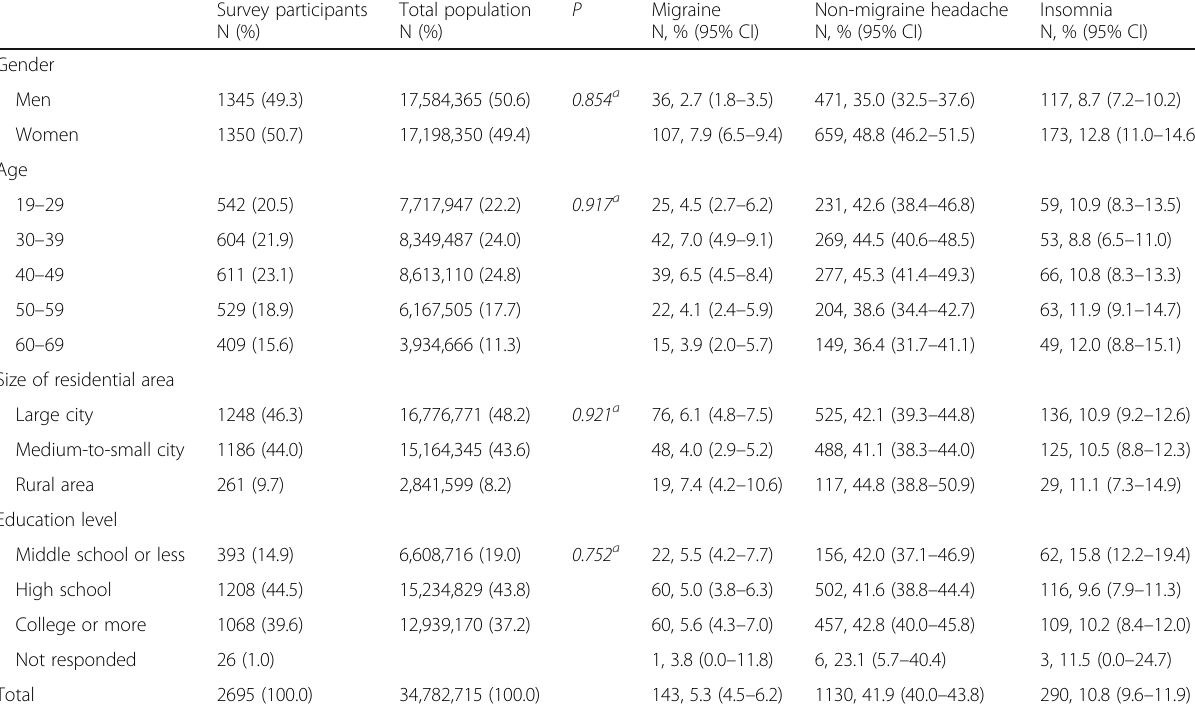
Table 1 Sociodemographic characteristics of survey participants, the total Korean population, and cases identified as having migraine, non-migraine headache, and insomnia